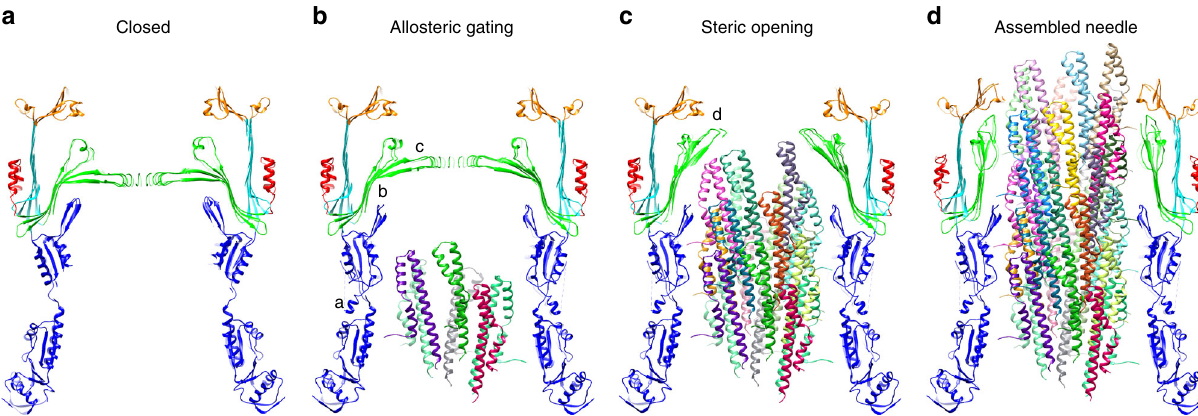
Fig. 6 Proposed secretin gating mechanism. a Closed secretin. b Initial rod/needle polymerization within the secretin lumen contacts the N3 domain triggering the ordering of the variable N3 loop a providing lateral stability and altering the N3 domain-inner β -barrel interface b . This in turn disrupts the interactions of the N3 β -INSERTION with the GATE1 and GATE2 kinks and unlocks the gate c . c Continued needle polymerization sterically pushes the gate open d . d Final assembled needle with fully open